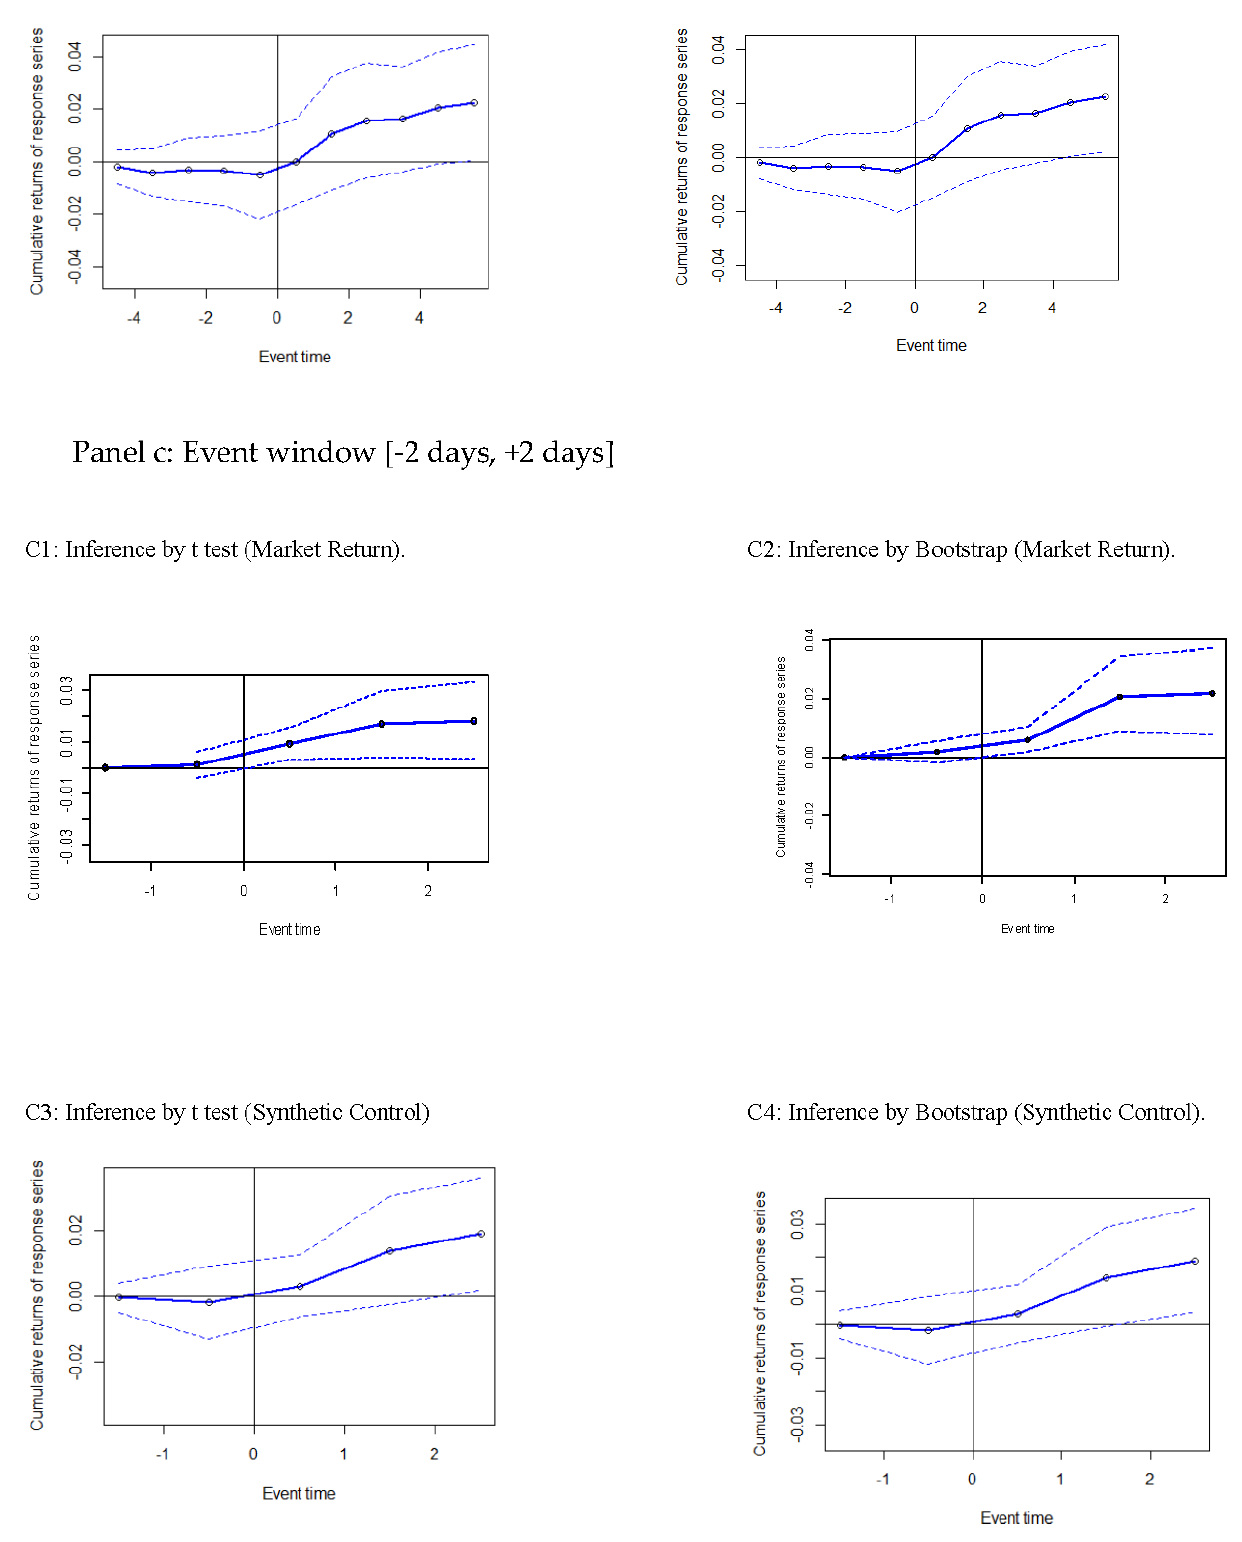
Figure 4. Accumulated abnormal returns of analyzed events. Note: The blue dotted lines represent a 95% confidence interval for the accumulated abnormal return. The vertical line indicates the moment when the event was announced.